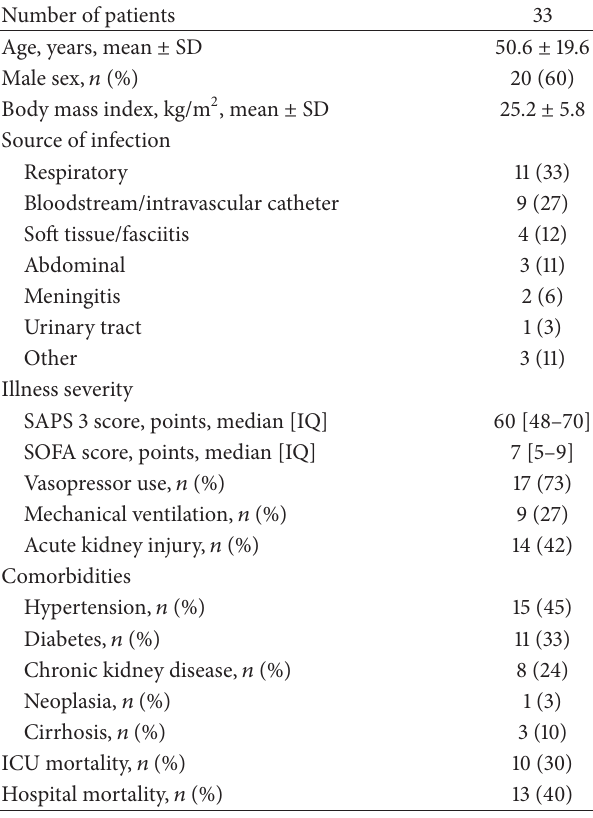
Table 1: Demographic and clinical features. Table 2: Serum levels and results for generalized additive